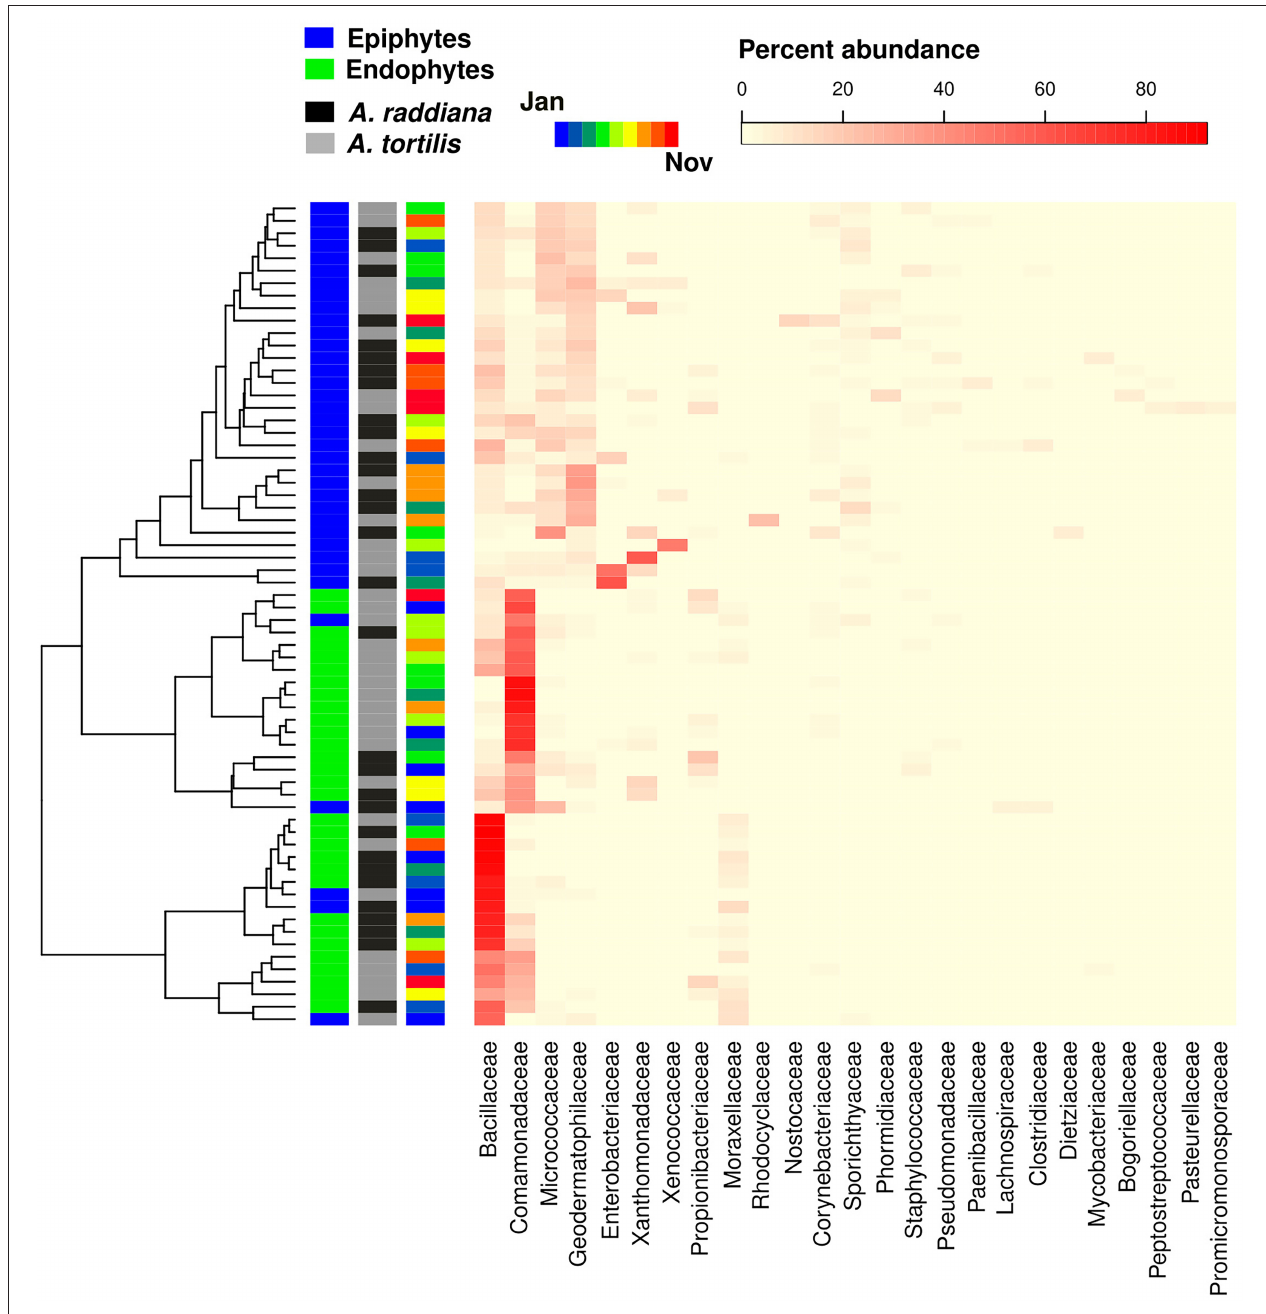
FIGURE 6 | Heatmap showing the abundance of bacterial family abundances ( x axis) for each of the sampled epiphytic and endophytic bacterial communities at the south canopy side at different sampling months (January–November).